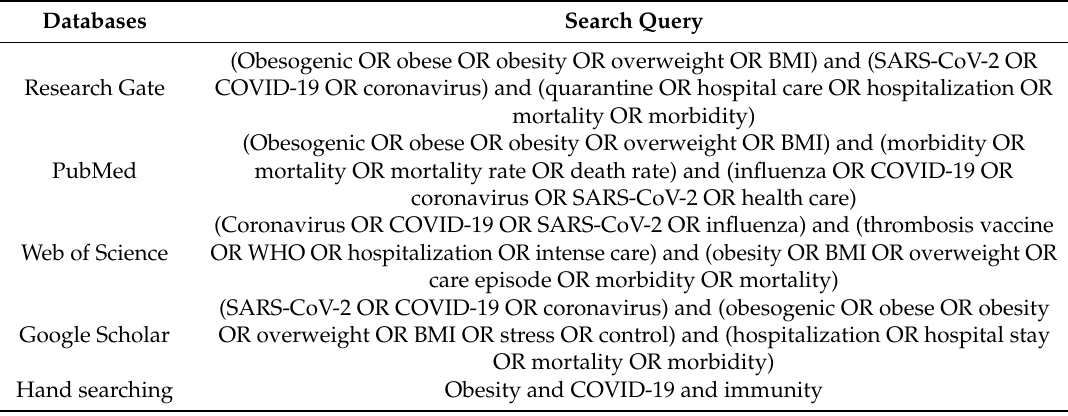
Table 1. Search queries of this comprehensive